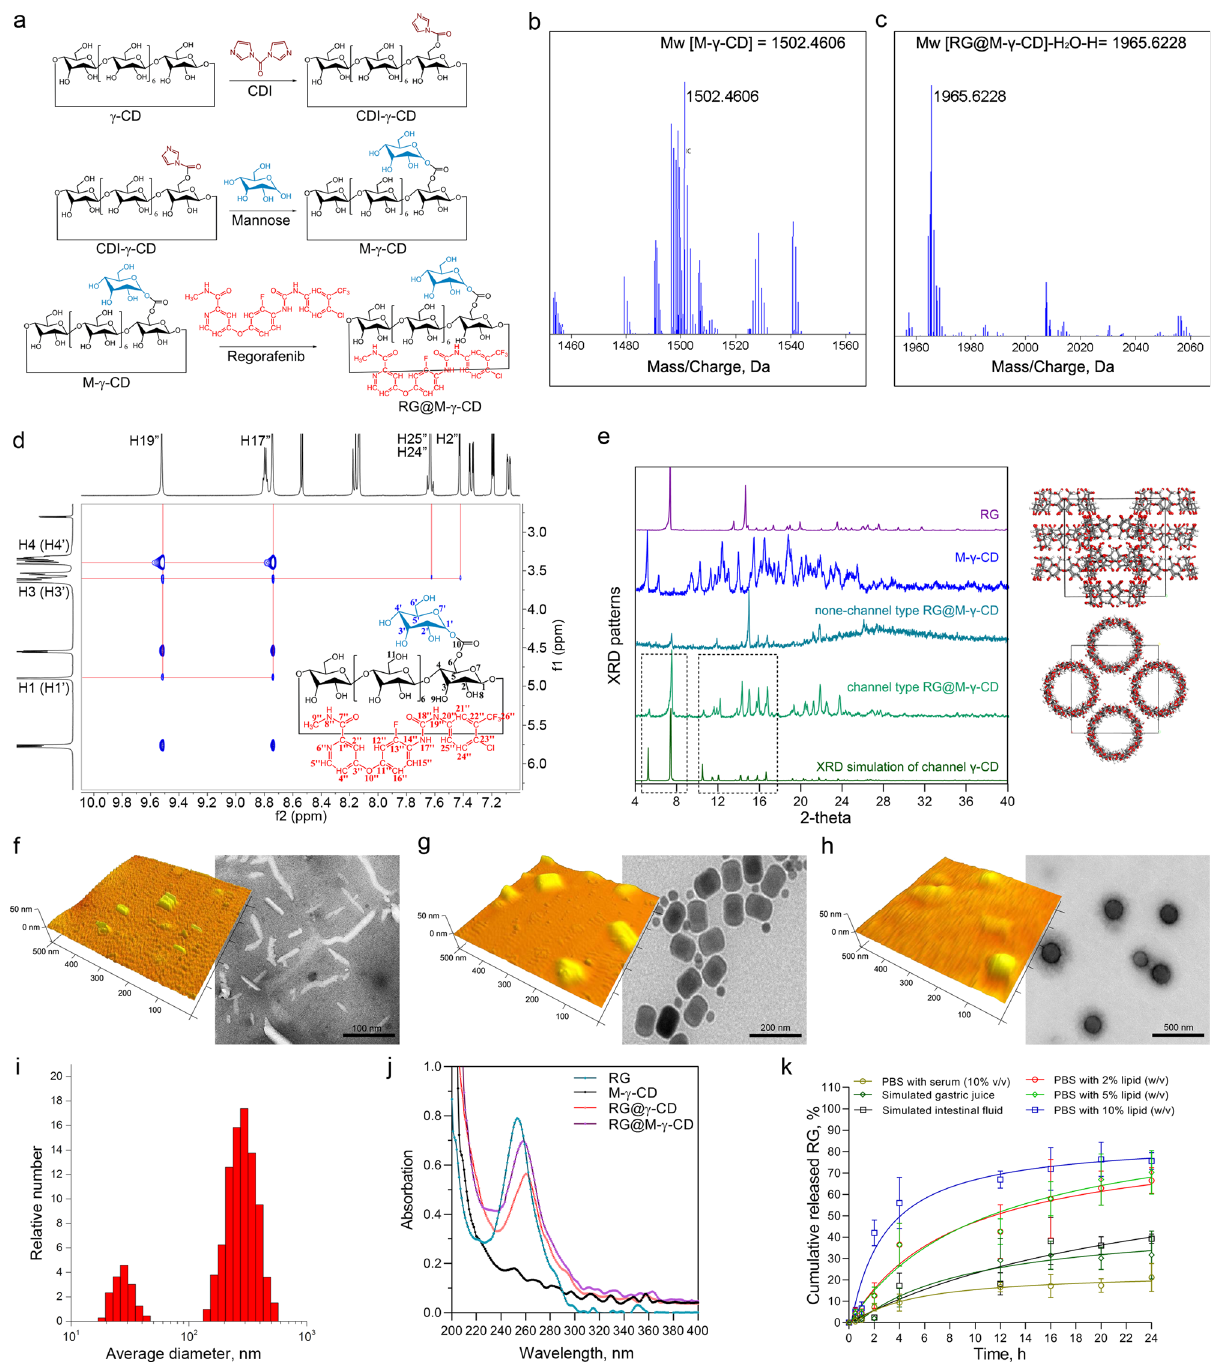
Fig. 2 Synthesis and chemical characterization of RG@M- γ -CD. a Synthetic procedure of RG@M- γ -CD, including activation of γ -CD by 1,1 ′ - carbonyldiimidazole (abbreviated as CDI) (upper), functionalization of γ -CD with mannose (middle) and construction of inclusion complex, RG@M- γ -CD (lower). b , c ESI-TOF-MS analysis on M- γ -CD and RG@M- γ -CD. d Partial magni fi cation of 2D NOESY spectrum of RG@M- γ -CD. e XRD patterns of RG, M- γ -CD, none channel-type RG@M- γ -CD, channel-type RG@M- γ -CD, and stimulated channel-type γ -CD. Schematic illustration of γ -CD stacking